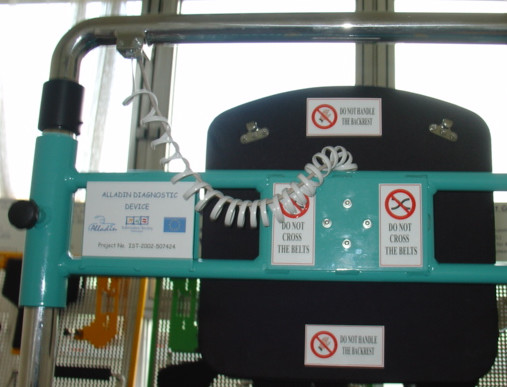
The Trunk Device.